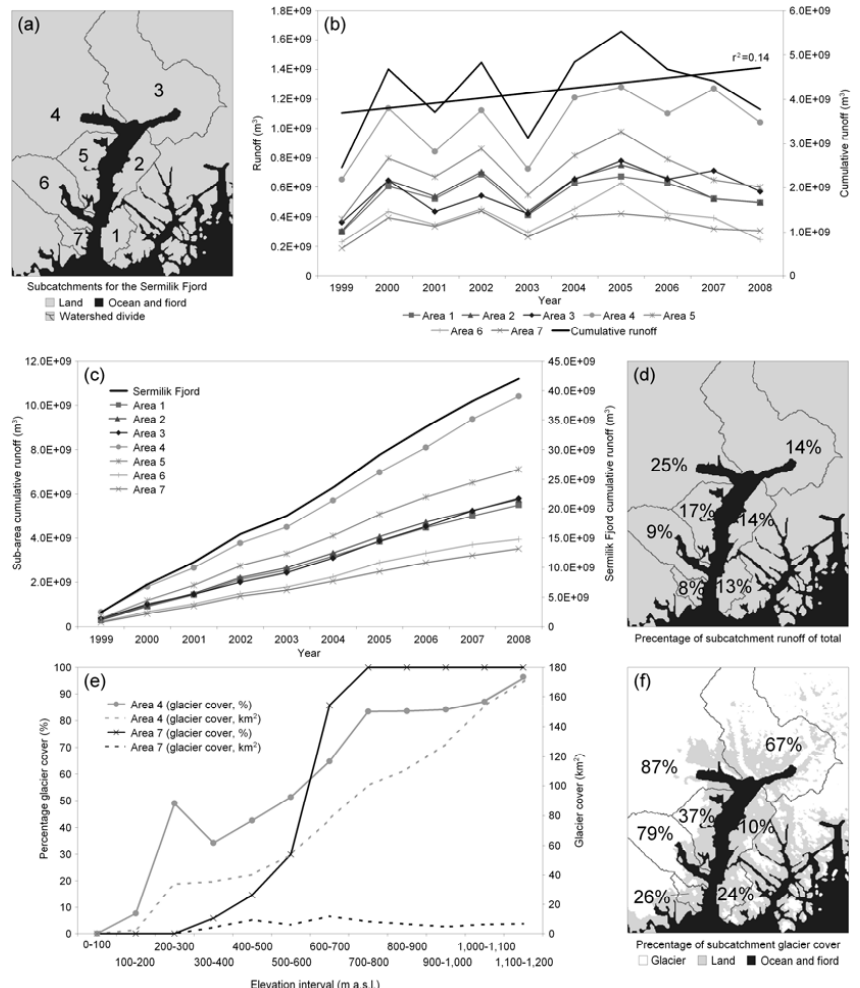
Figure 4: (a) Area of interest including the seven sub-catchments for the Sermilik Fjord (simulated in River Tools; a GIS application for analysis and visualization of digital treeain, watersheds, and river network); (b) time series (1999–2008) of annual sub-catchment simulated runoff and annual cumulative runoff, including trend line (linear) for cumulative runoff; (c) cumulative sub-catchment runoff and overall runoff; (d) percentage of sub-catchment runoff of total runoff; (e) glacier cover distribution in percentage and square kilometer within the elevations from where runoff occurred for the sub-catchment with the lowest cumulative runoff (sub-catchment 7) and the highest (sub-catchment 4); and (f) the percentage of sub-catchment glacier cover within the area of interest. 27